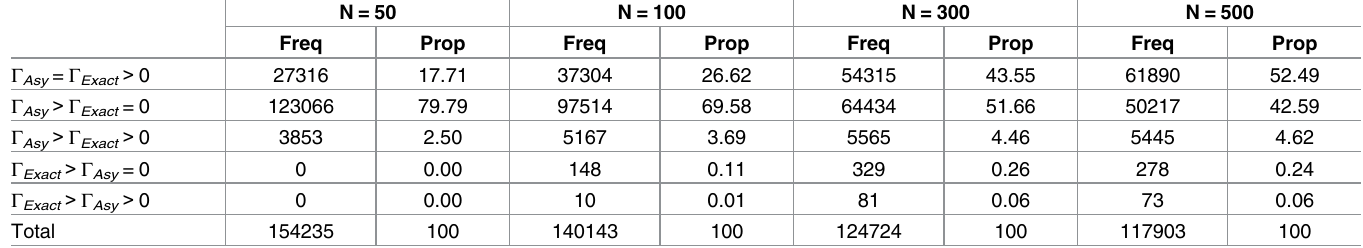
Table 8. For a 5 × 5 contingency table, frequency (Freq) and proportion (Prop) of simulated data having at least one cell is significant based on either T AdjR or exact p-value, from a total of 2 million simulations. Γ Asy and Γ Exact are the numberof cells with significantp-valuesby using the asymptotic approachand the exact